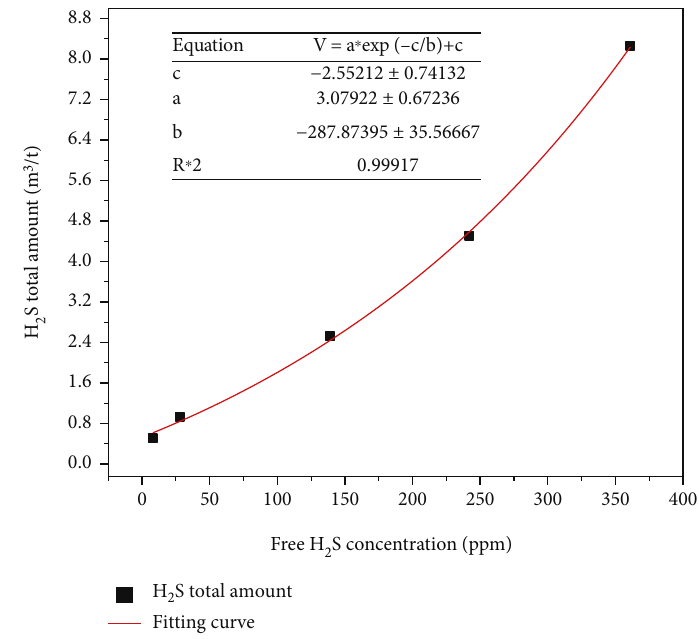
Figure 5: Relation curve between free H